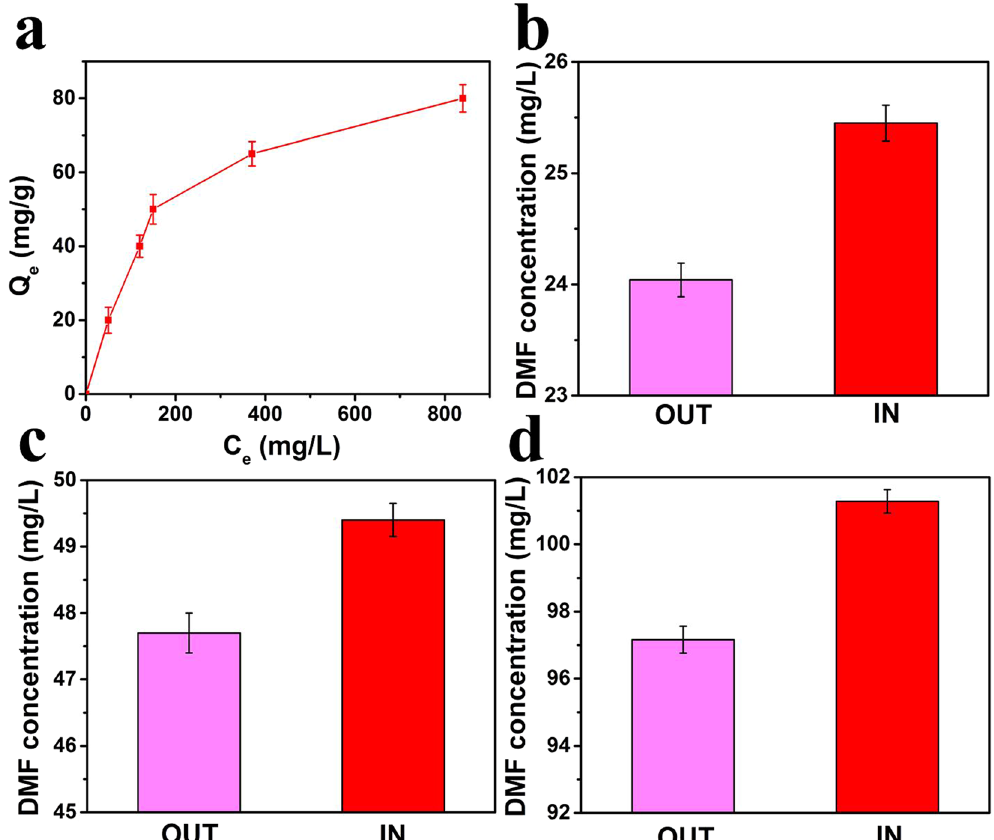
Figure 6. The adsorption isotherms of PGO ( a ) and the difference of DMF concentration for inside and outside of CM@PGO at the initial concentration = 25 mg/L ( b ), 50 mg/L ( c ), 100 mg/L ( d ) (DMF solution volume = 50 mL and T = 30